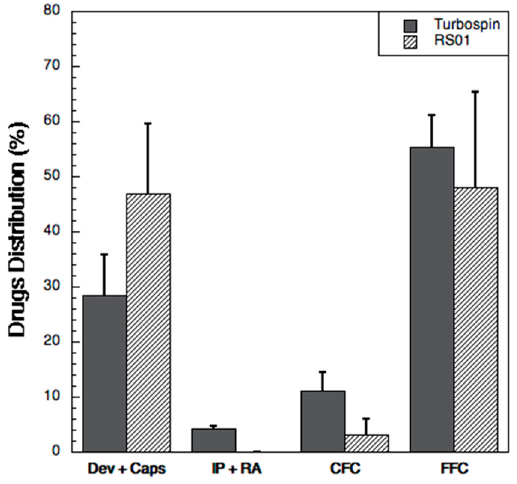
Figure 4. Drug distribution (% of the loaded amount) of the three drugs (sum of them) upon aerosolization with RS01 ® and Turbospin ® in the Fast screening impactor: device and capsule (Dev + Caps), induction port and rubber adaptor (IP + RA), coarse fraction collector (CFC) and fine fraction collector (FFC). Data are expressed as mean of the values obtained for each drug in each analysis; the bars represent the standard deviation ( n = 3). Table 2. Emitted Dose (ED), Emitted Fraction (EF), Fine Particle Dose (FPD) and Fine Particle Fraction (FPF) obtained upon aerosolization with the two devices, referred to the single drugs ( n = 3 standard deviation).